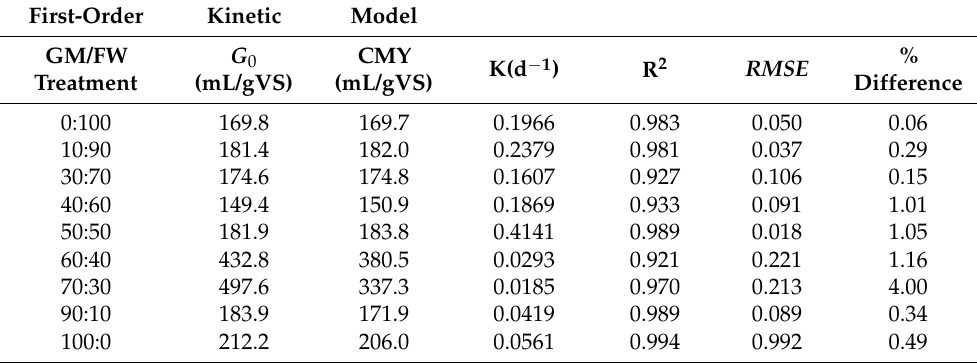
Table 2. The first-order kinetic model parameters for GM: FW ratios.